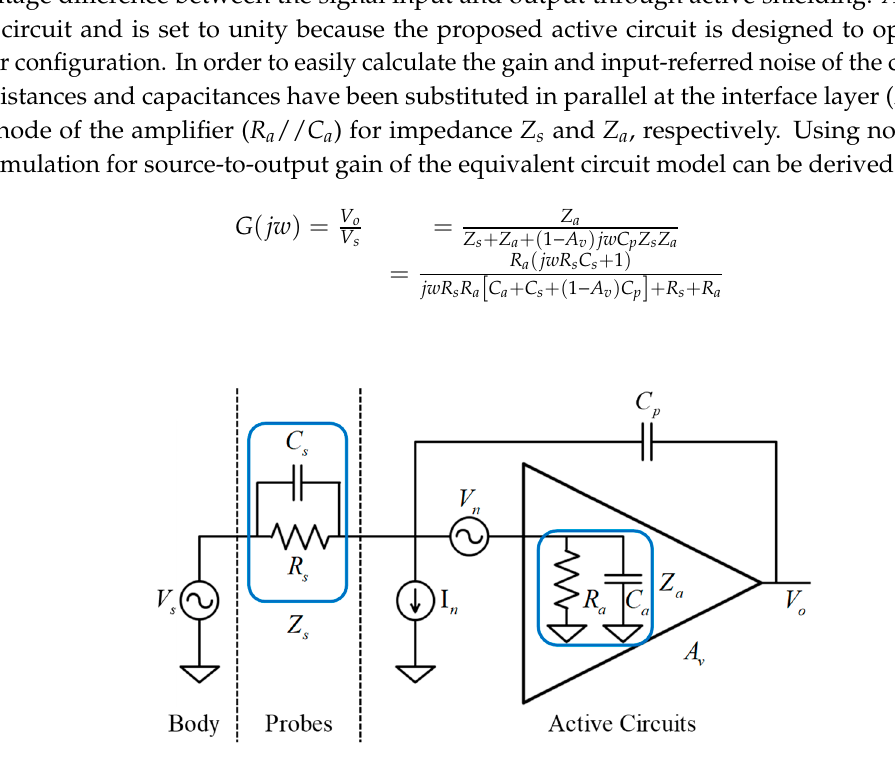
Figure 2. Equivalent circuit model of the proposed active spring-loaded electrodes.